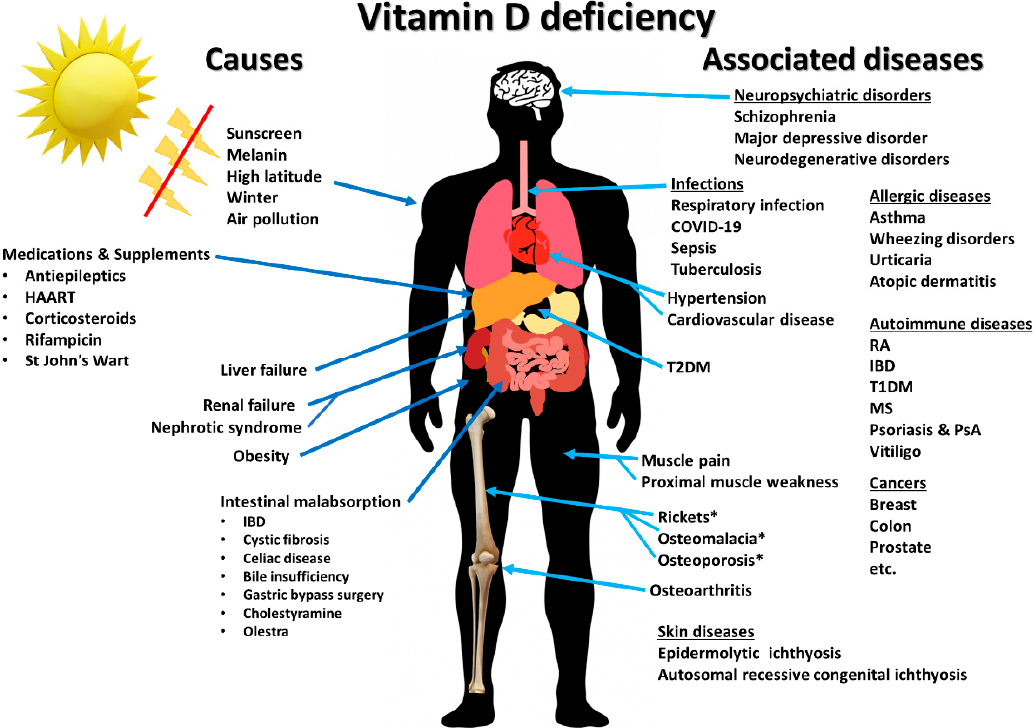
Figure 1. Summary of causes of vitamin D deficiency and diseases and disorders associated with